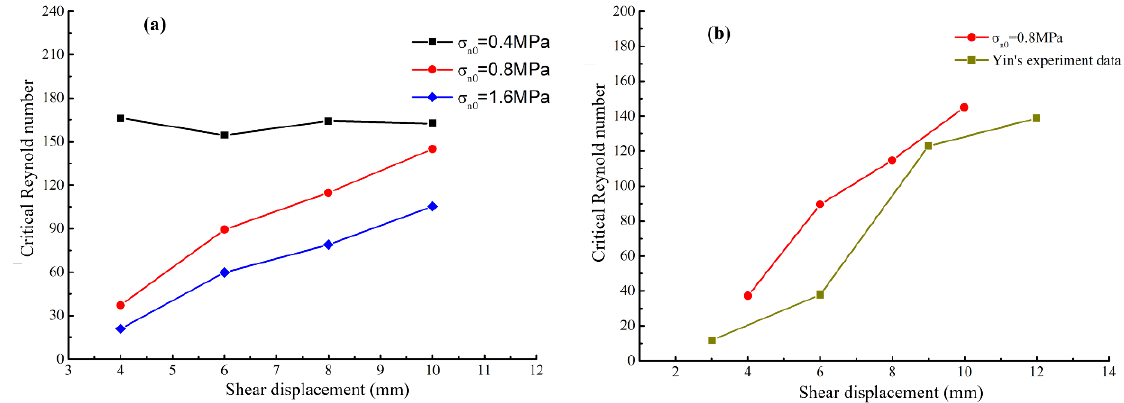
Figure 8. Relationship between Reynolds number and shear displacement, ( a ) relationship between Reynolds number and shear displacement under different initial normal stress; ( b ) comparison of Reynolds number between simulation result and Yin’s experiment data [33].